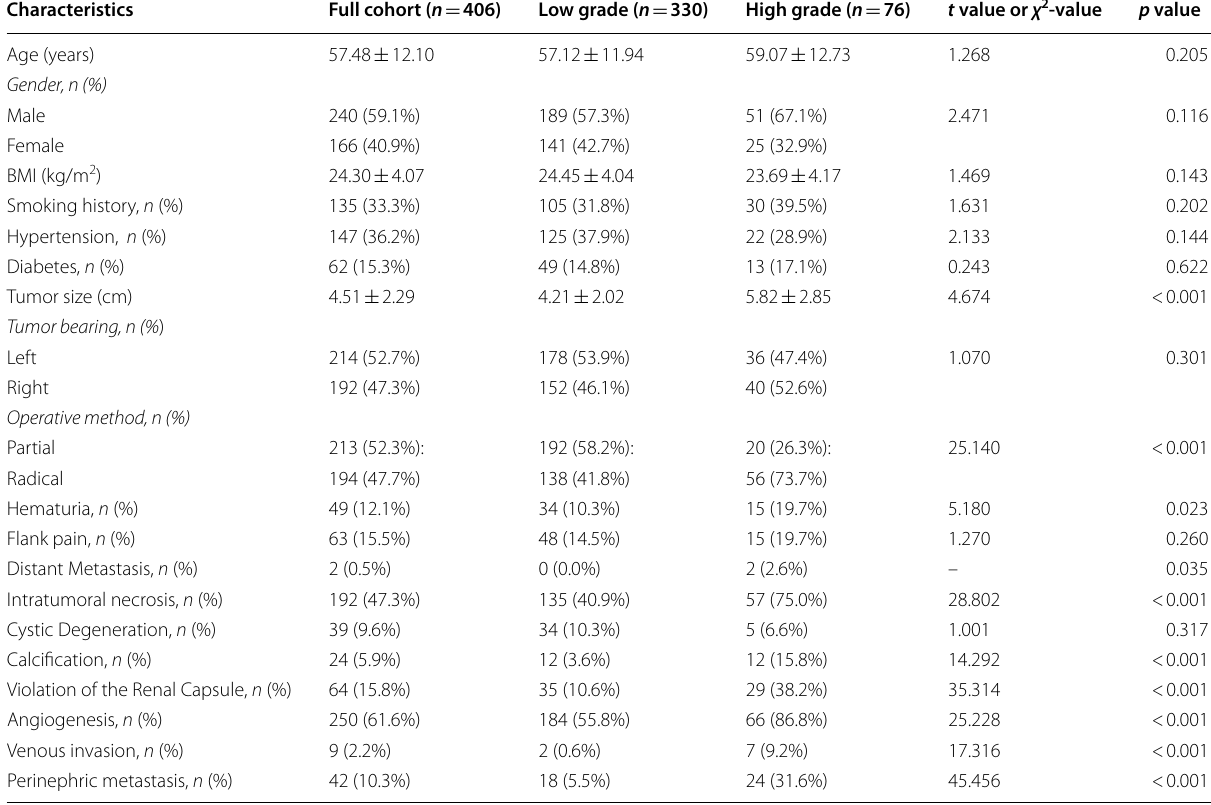
n number, BMI body mass index